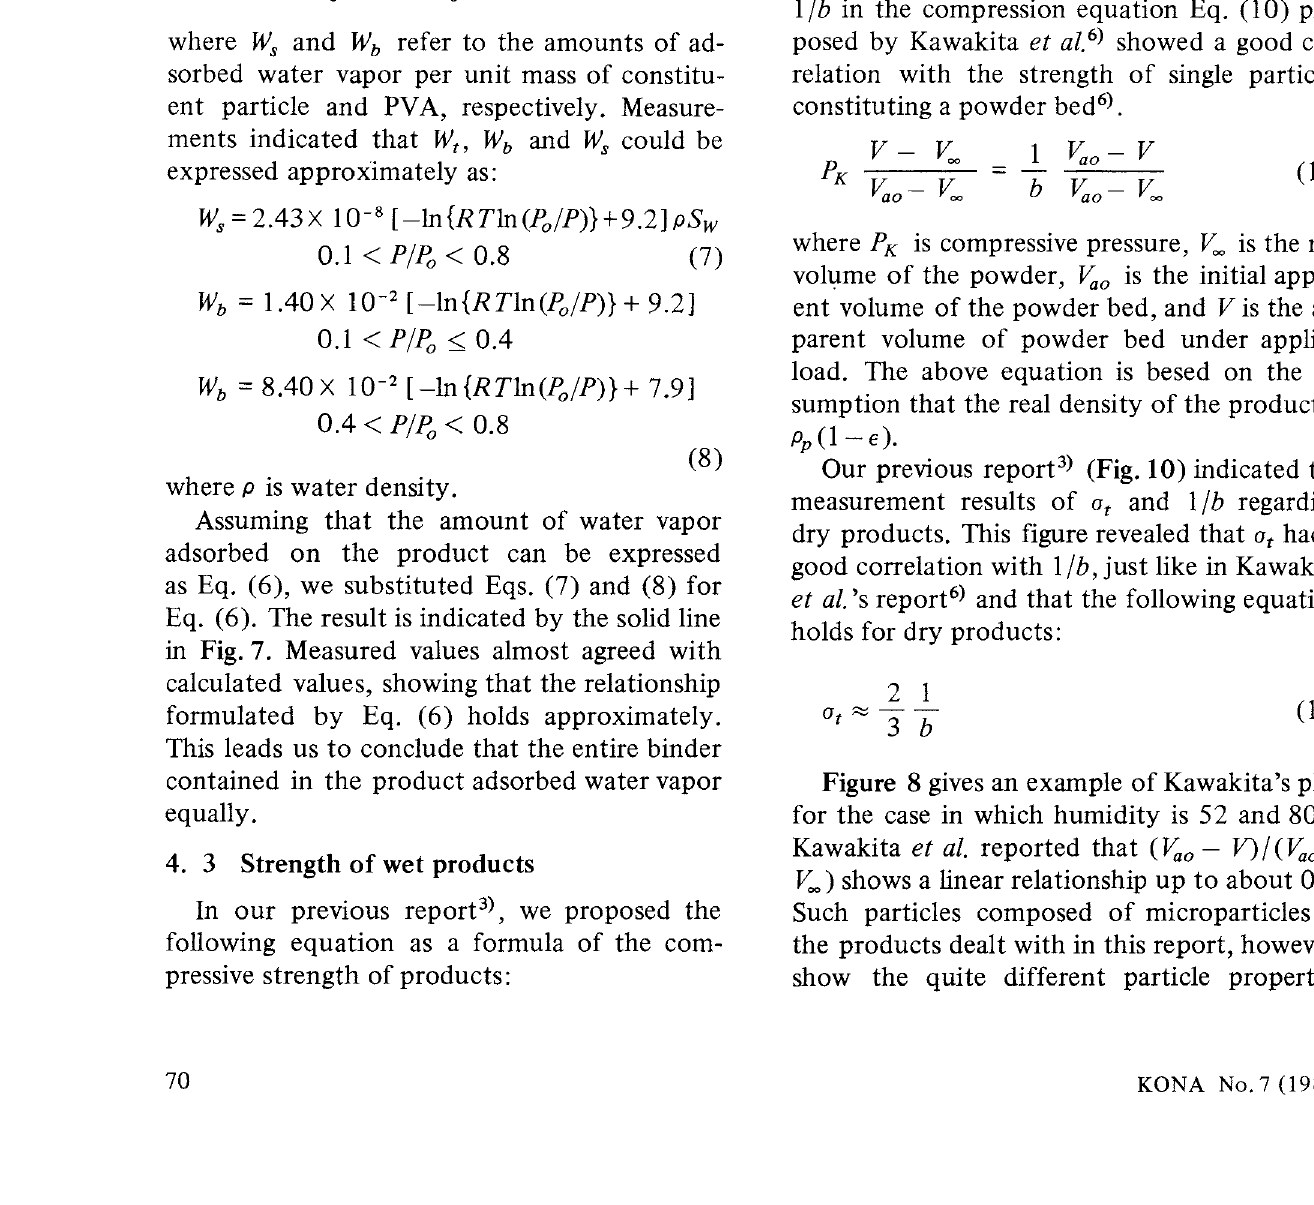
Fig. 7 Relationship between adsorption potential of water vapor and thickness of the adsorption